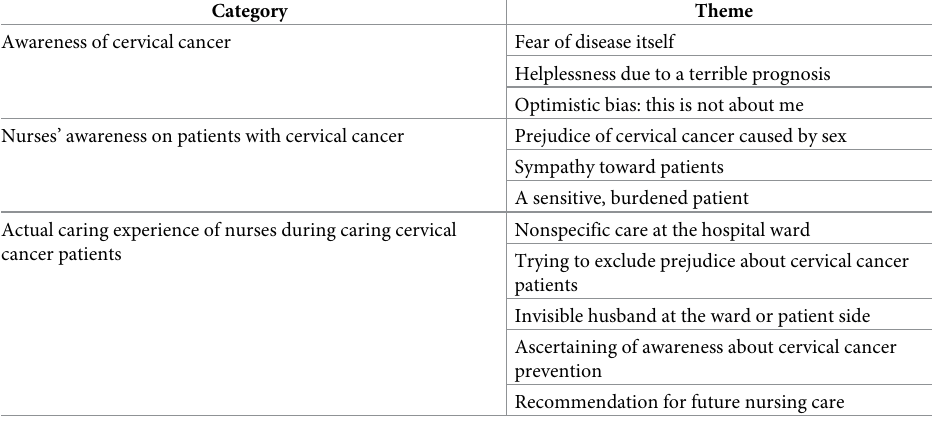
Table 2. Awareness of cervical cancer and nurses’ caring experience about their cervical cancer